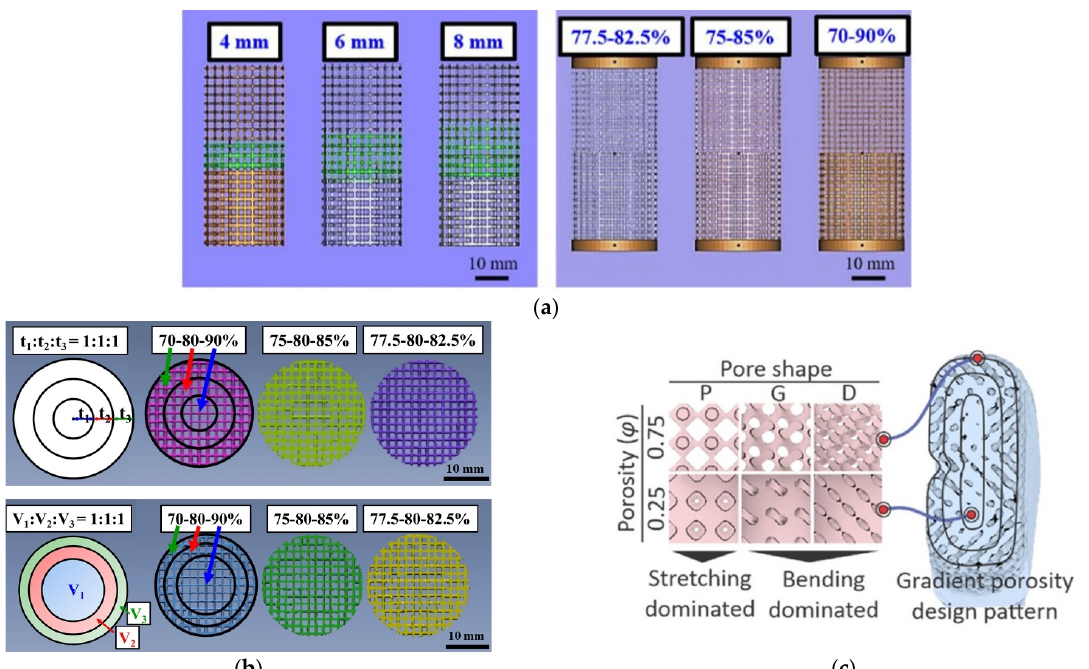
Figure 6. ( a ) Longitudinal Gradient Porous Implants. Reprinted with permission from ref. [97]. 2018, Elsevier Ltd. ( b , c ) Radial Gradient Porous Implants. Reprinted with permission from ref. [96,99]. 2021, Elsevier Ltd. and 2021, American Chemical Society.